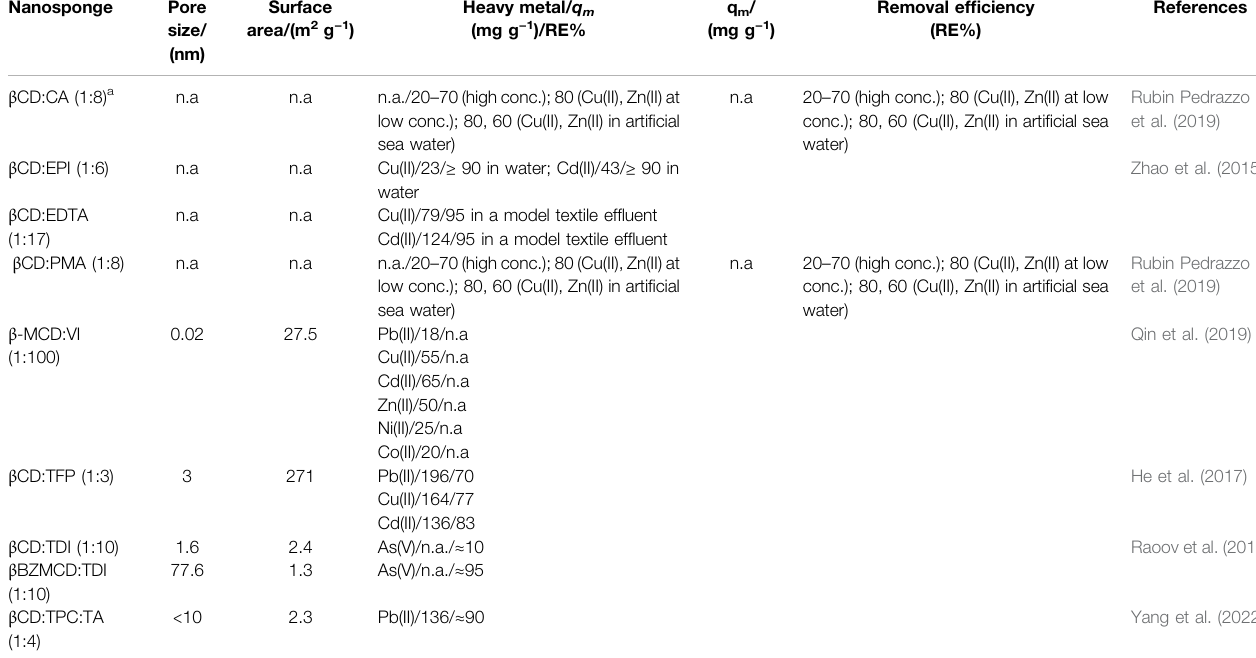
TABLE 4 | Recap of the main results of heavy metals removal by different nanosponge formulations.